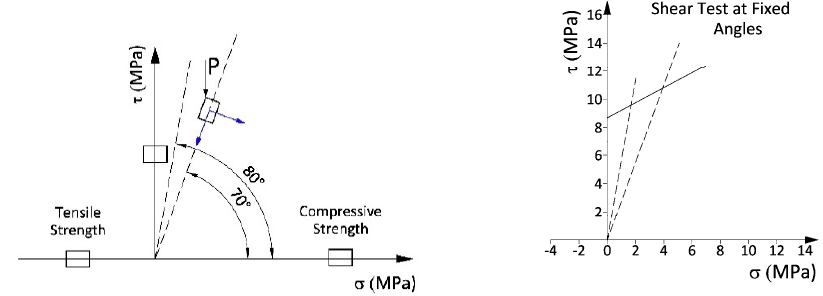
Figure 2. Schematic drawing showing shear test at fixed angles with respect to normal stresses ( σ ), in order to obtain points for linear Mohr–Coulomb (MC) model.